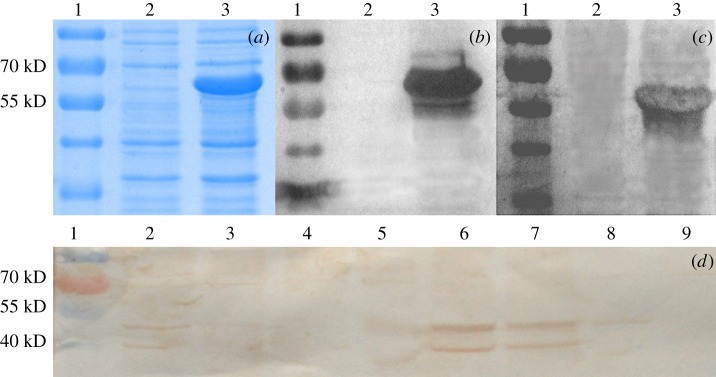
Expression of recombinant BmYki1 in E. coli and detection of BmYki in the different tissues of the silkworm. (a) SDS-PAGE for the recombinant BmYki1 expressed in E. coli, Lane 1, protein marker; Lane 2, transformed E. coli Transetta (DE3) strain with pET-28a(+); Lane 3, transformed E .coli Transetta (DE3) strain with pET-28a(+)-BmYki1. (b) Western blotting for recombinant BmYki1 expressed in E. coli; Lanes 1–3 are as described above. Mouse anti-His6 antibody was used as primary antibody; the secondary antibody was HRP-conjugated goat anti-mouse IgG. (c) Mouse anti-BmYki1 antibody was used to detect the recombinant BmYki1 expressed in E. coli with western blotting; the secondary antibody was HRP-conjugated goat anti-mouse IgG; Lane 1, protein marker; Lane 2, transformed E. coli Transetta (DE3) strain with pET-28a(+); Lane 3, transformed E.coli Transetta (DE3) strain with pET-28a(+)-BmYki1; (d) Detection of BmYki in the different tissues at day 3 of the 5th instar by western blotting; Lane 1, protein marker; Lane 2, testis; Lane 3, ovary; Lane 4, head; Lane 5, midgut; Lane 6, silk gland; Lane 7, fat body; Lane 8, malpighian tube; Lane 9, tracheal plexus. The primary antibody was a mouse anti-BmYki antibody and the secondary antibody was HRP-conjugated goat anti-mouse IgG.